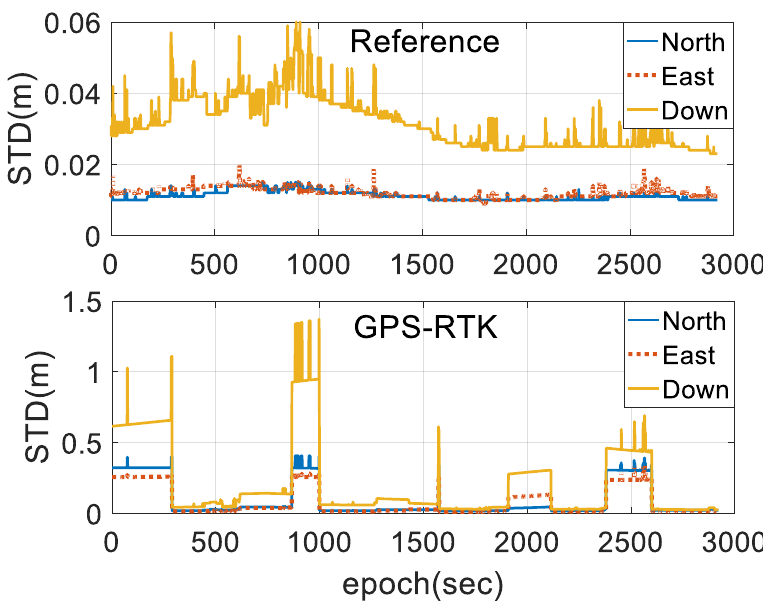
Figure 7. Position state estimate error of the referenced and GPS-RTK.